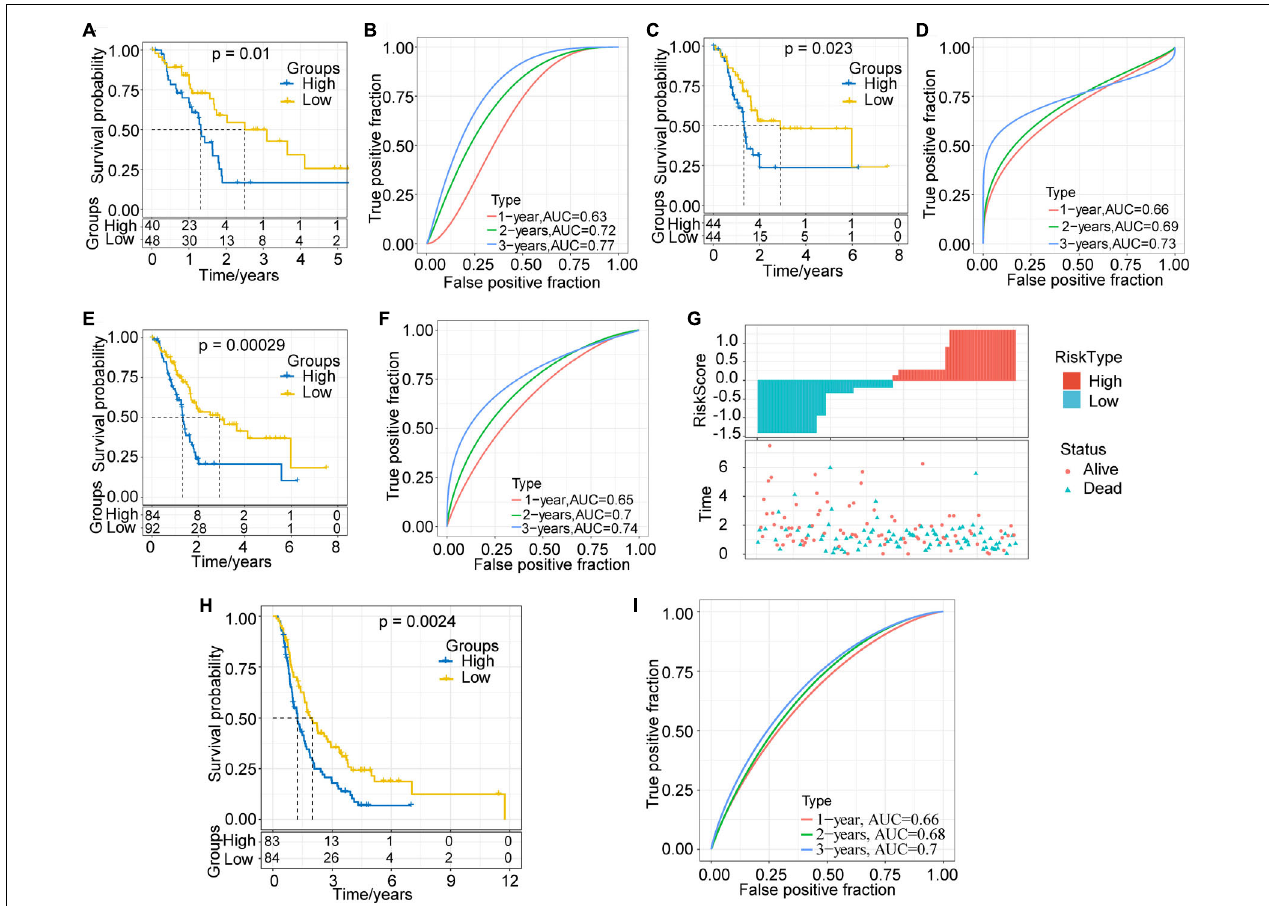
FIGURE 6 | Evaluation and validation of prognostic models. (A) KM survival curve distribution of the high-risk group and the low-risk group in the training set. (B) ROC curve of the prognostic model in the training set. (C) KM survival curve distribution of the high-risk group and the low-risk group in the validation set. (D) ROC curve of the prognostic model in the validation set. (E) KM survival curve distribution of the high-risk group and the low-risk group in all samples of the TCGA-PAAD cohort. (F) ROC curve of the prognostic model of all samples. (G) Correlations among RiskScore, survival time and survival status of the TCGA-PAAD cohort; RiskScore is arranged from low to high. (H) KM survival curve distribution of the high-risk group and the low-risk group in the ICGC-PACA-CA cohort. (I) ROC curve of the prognostic model in the ICGC-PACA-CA